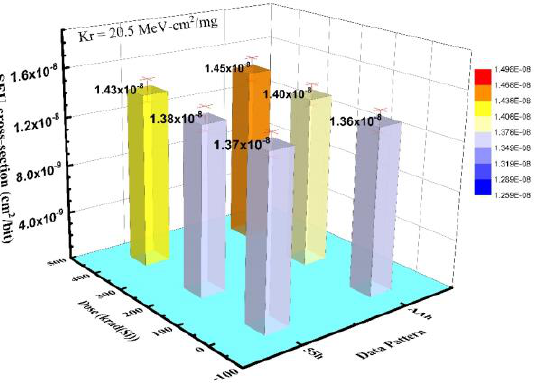
Figure 5. SEU cross-sections characterized by Kr ion versus TID for 6T SRAMs under different data